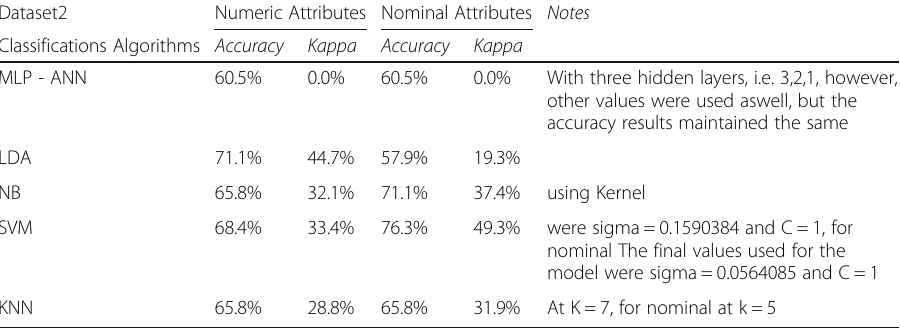
Table 7 Accuracy and Kappa results for nominal & numeric attributes for dataset 2